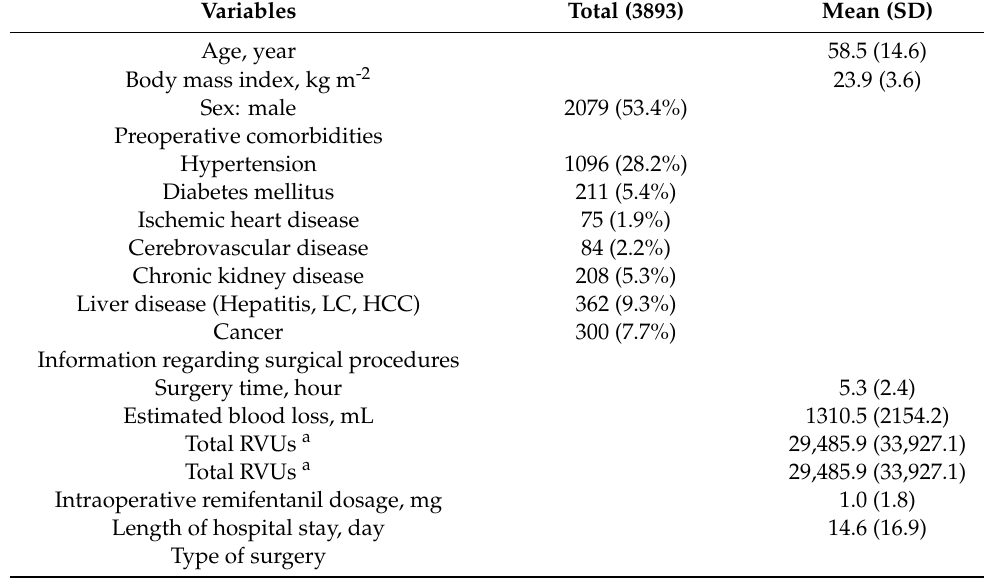
Table 1. Characteristics of patients who received major abdominal surgery in